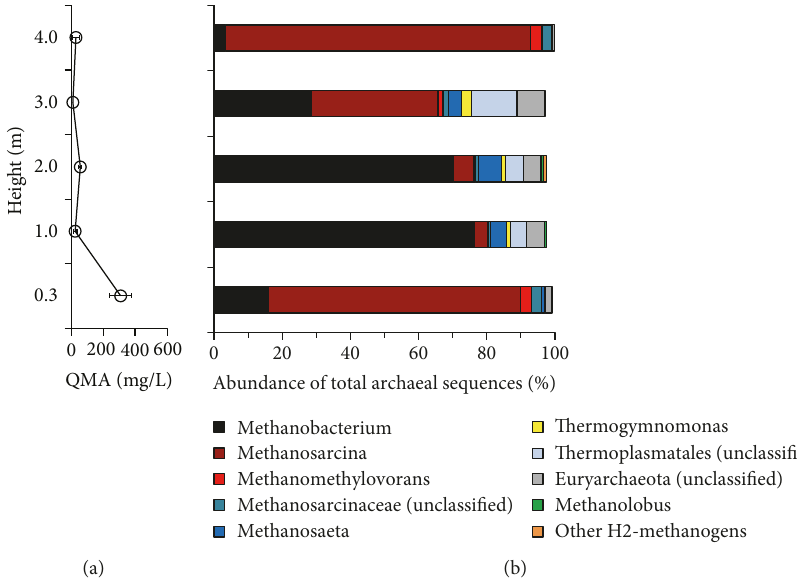
Figure 2: Tetramethylammonium (QMA) pro fi le (a) and quantitative distribution of archaeal populations in the full-scale UASB reactor for treating tetramethylammonium-rich wastewater as revealed by the pyrosequencing 16S rRNA gene amplicons (sequence abundance > 0.8%) (b). “ Other H methanogens ” included the low abundant populations, namely, Methanolinea ( < 0.07%), Methanoculleus ( < 0.01%), 2 Methanospirillum ( < 0.03%), Methanobrevibacter ( < 0.03%), Methanosphaera ( < 0.01%), and Methanococcus ( <